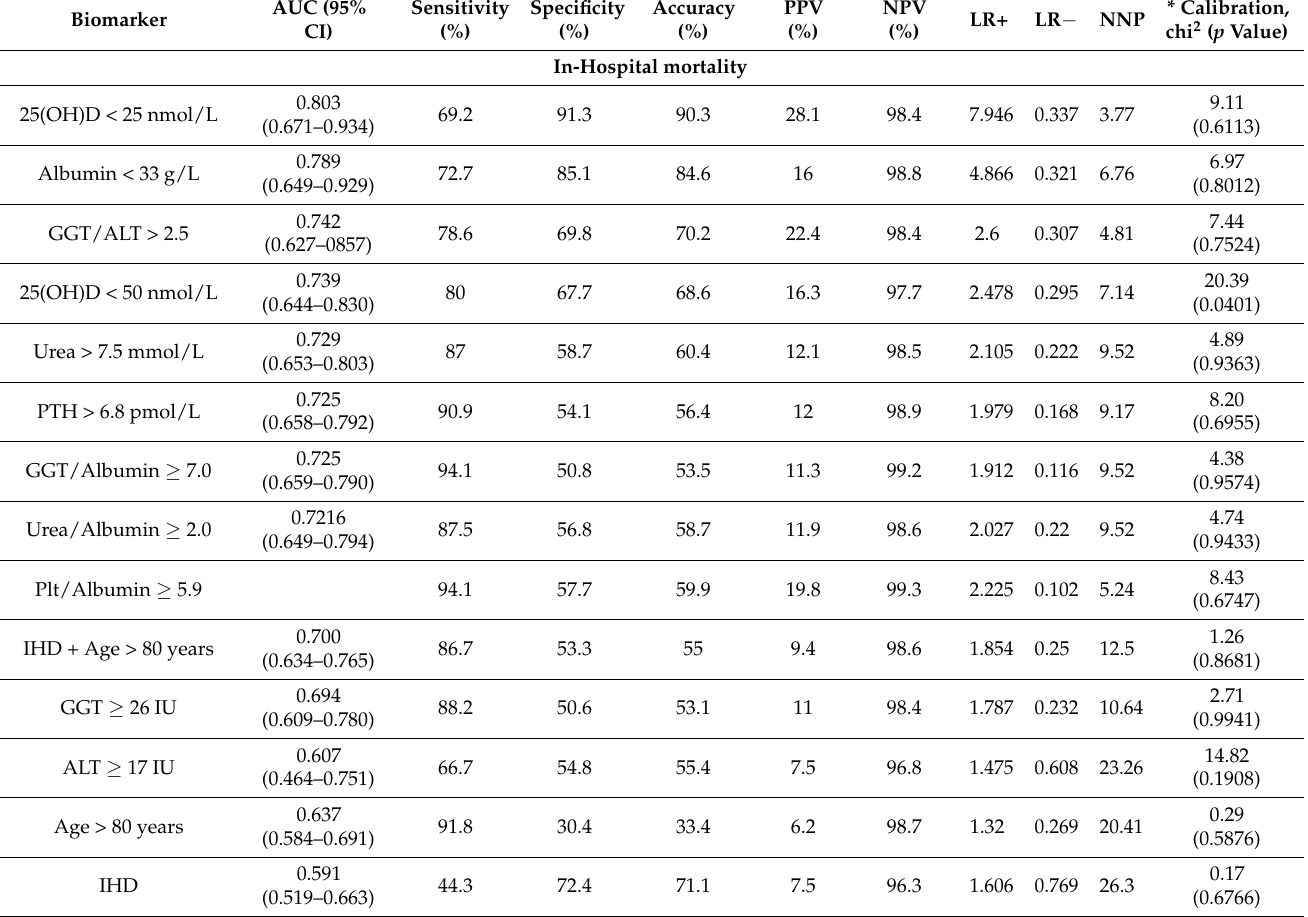
Table 4. Summary of performance parameters of biomarkers at admission to predict